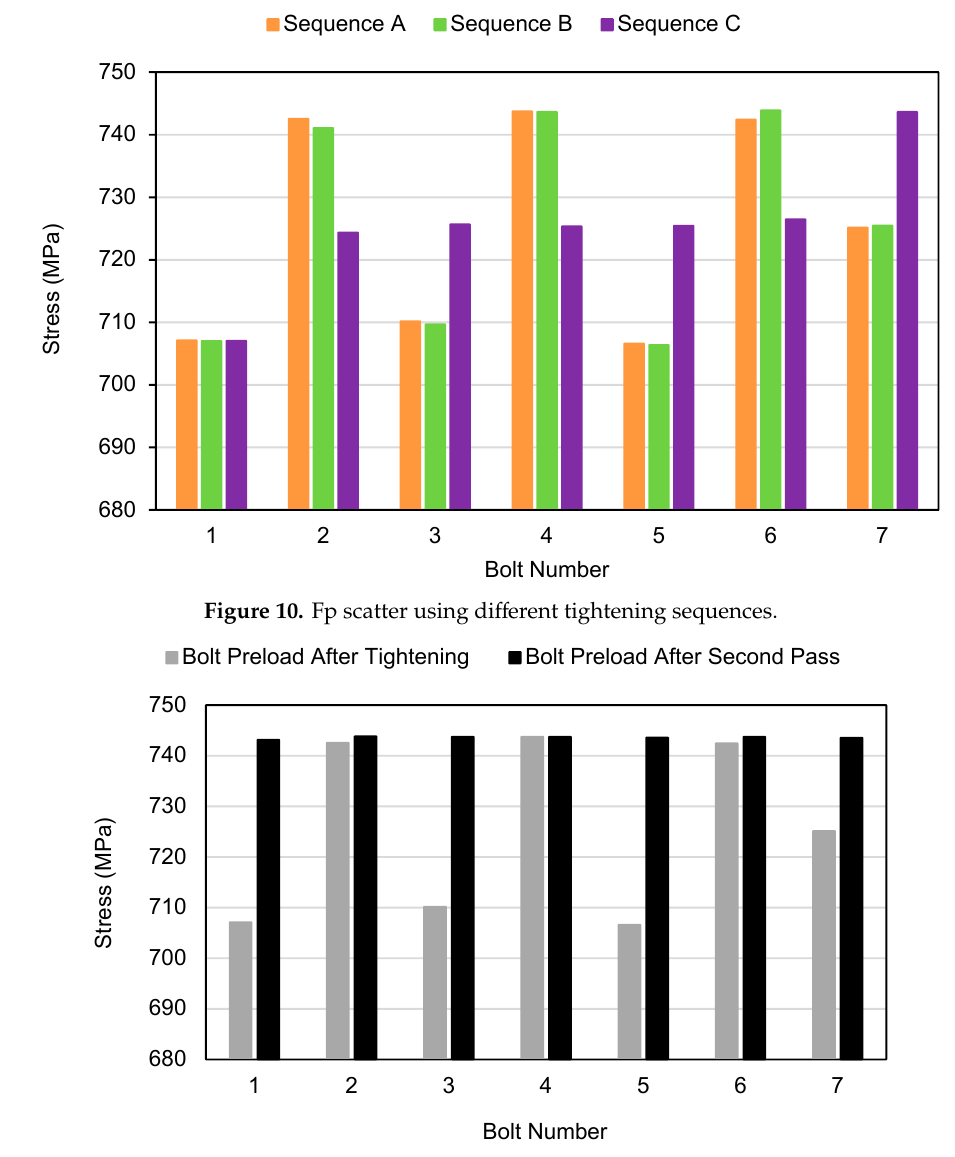
Figure 11. Fp scatter difference between first and second pass .